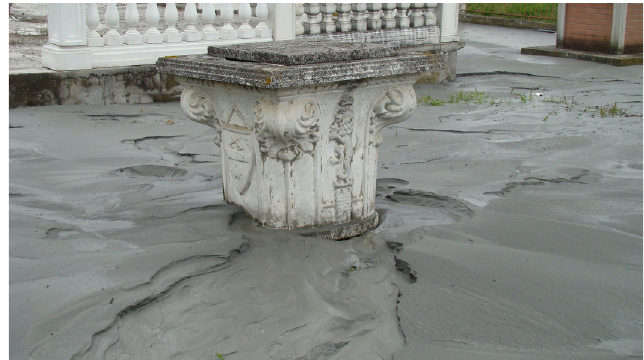
Figure 2. Example of sand ejection from a large-diameter water well at the base of the levee associated with an abandoned reach of the Reno River (San Carlo-Sant'Agostino road).